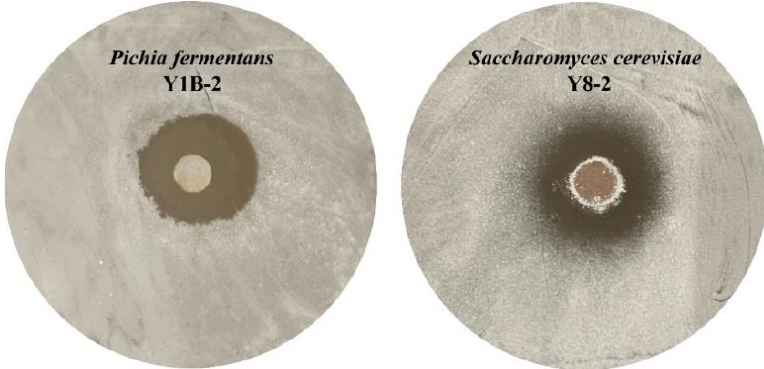
Table 1. The R inhibition zone/R colony values of the six strains.